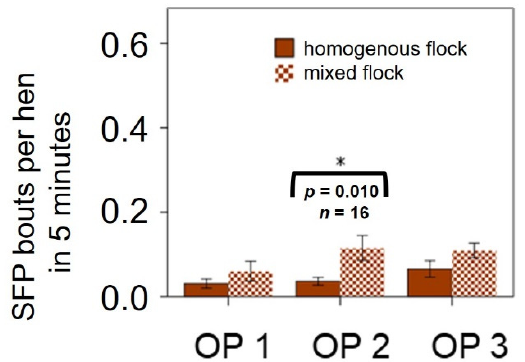
Figure 2. Severe feather pecking (SFP) rate in non-beak-trimmed Lohmann Brown (LB) hens in homogeneous (LB only) and mixed (LB + another hybrid line) flocks in the litter area during the laying period. Observation Period (OP) 1: 28th to 33rd week of life; OP 2: 42nd to 48th week of life; OP 3: 63rd to 68th week of life; n = number of cameras. Statistical test: Mann–Whitney U-test, significant: (*) = p ≤ 0.050. The bracket indicates a significant difference.